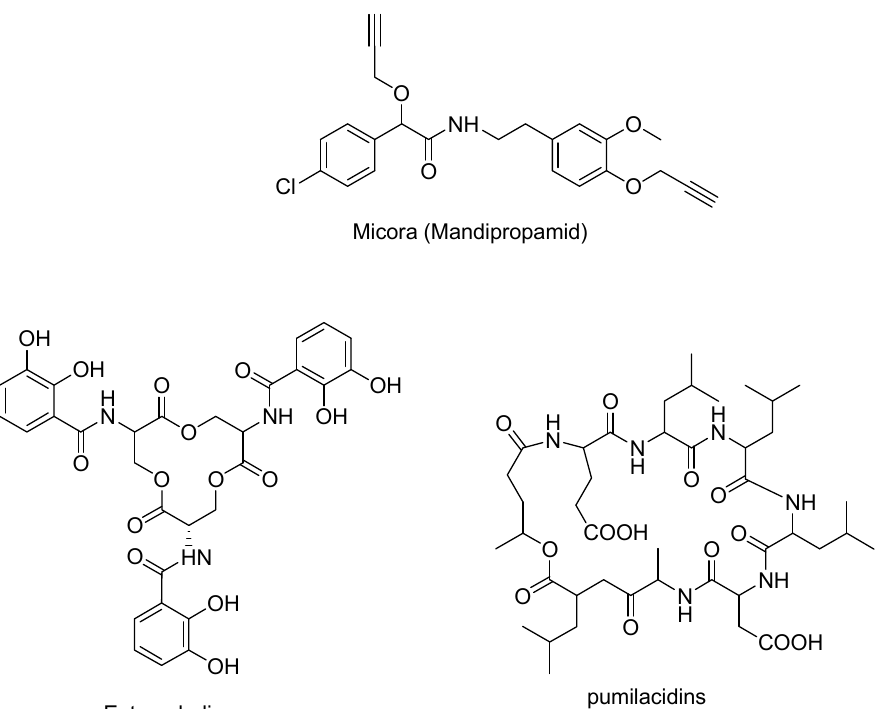
Figure 1. A few examples of pharmacologically active Passerini adducts.